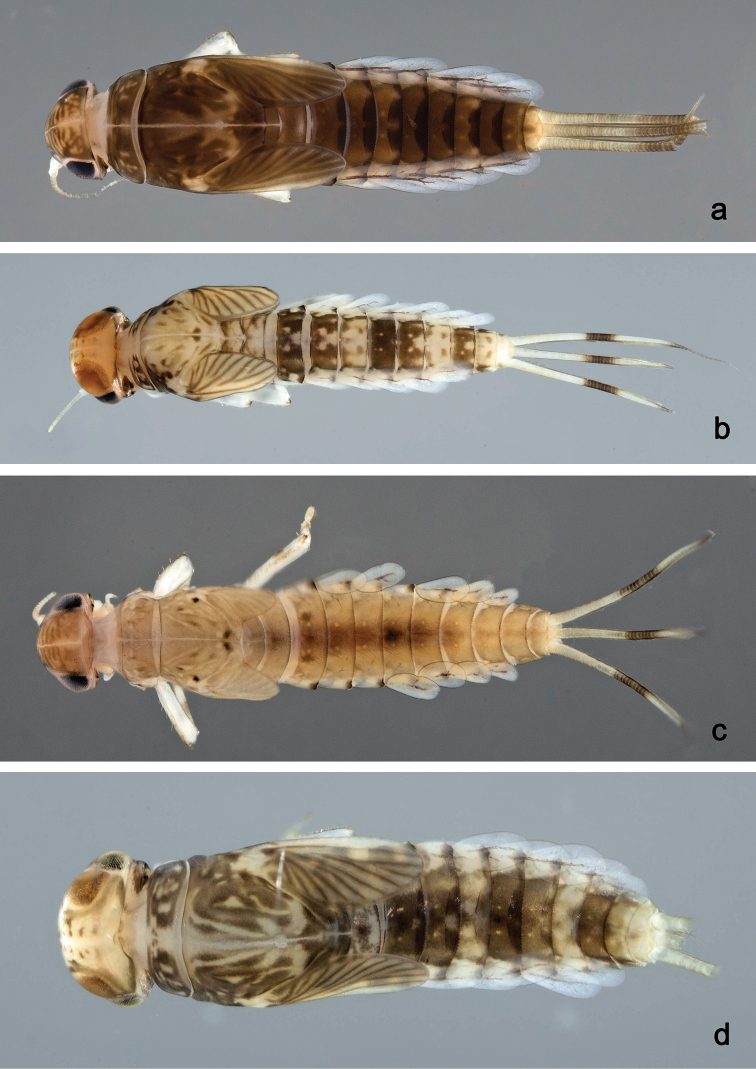
Habitus, larvae, dorsal view aLabiobaetis
camiguinensis sp. nov. bLabiobaetis
lachicae sp. nov. cLabiobaetis
palawano sp. nov. dLabiobaetis
sabordoi sp. nov.